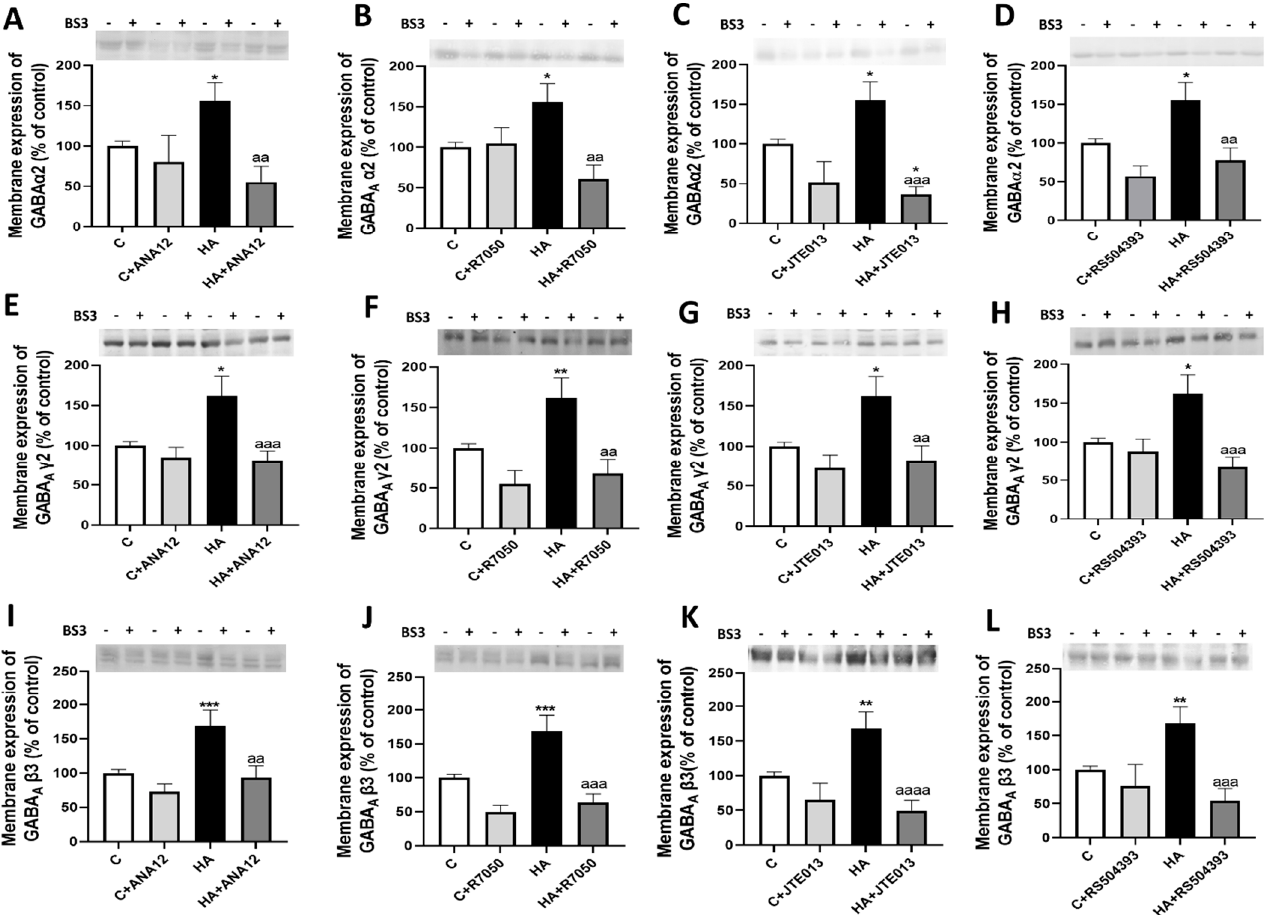
Figure 7. Hyperammonemia increases the membrane expression of GABAA receptor subunits α 2, γ 2, and β 3 in the cerebellum. Ex vivo treatment with ANA12, R7050, JTE-013, or RS504393 reverses these increases. The membrane expression of GABAA ( A – D ) α 2, ( E – H ) γ 2, and ( I – L ) β 3 in the cerebellum was analyzed using BS3 cross-linker procedure in slices from control (C) and hyperammonemic (HA) rats. The effects of blocking TrkB with ANA12, TNFR1 with R7050, S1PR2 with JTE-013, and CCR2 with RS504393 on membrane expression of this subunits of GABAA receptor are also shown. Values are the mean ± SEM of 15–24 rats per group. Values significantly different from control rats are indicated with asterisks, and from hyperammonemic rats are indicated with “a”. * p < 0.05, ** p < 0.01, *** p < 0.001; aa p < 0.01, aaa p < 0.001, aaaa p < 0.0001. ( A – L ) F values were 5.761, 5.959, 10.34, 8.885, 6.042, 7.936, 5.989, 6.573, 8.996, 12.06, 10.77, and 8.563, respectively. Data were